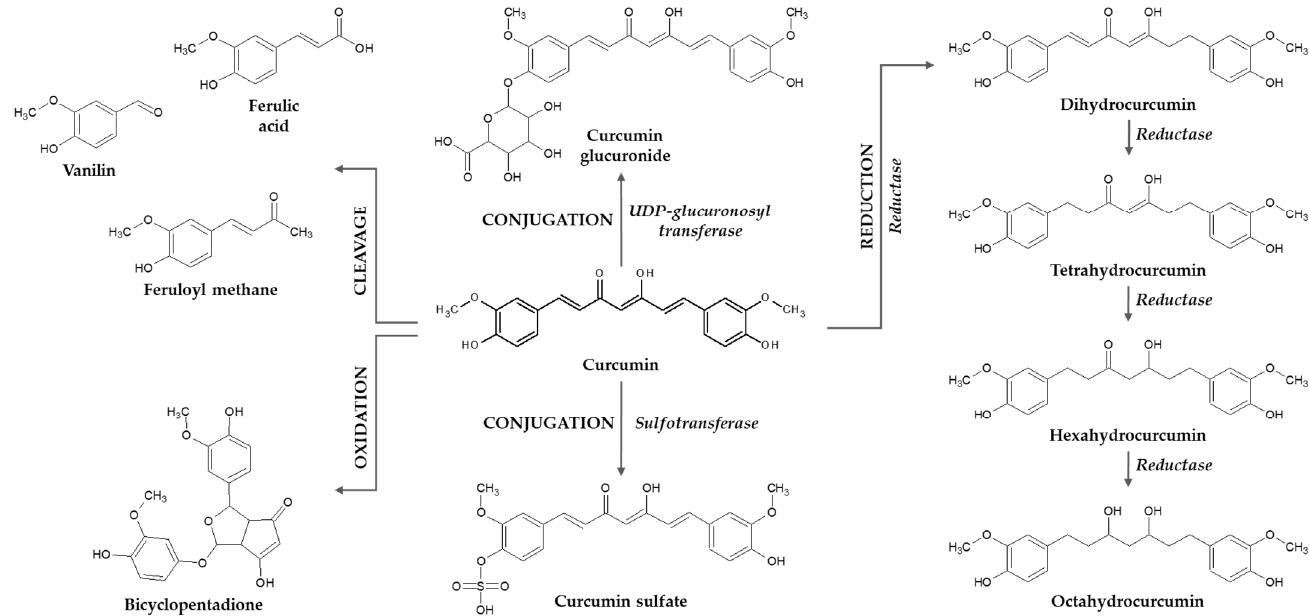
Figure 2. Curcumin metabolism—conjugation, reduction and cleavage.